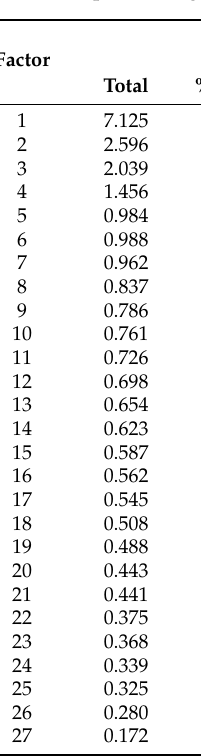
Table 2. Output of single-factor